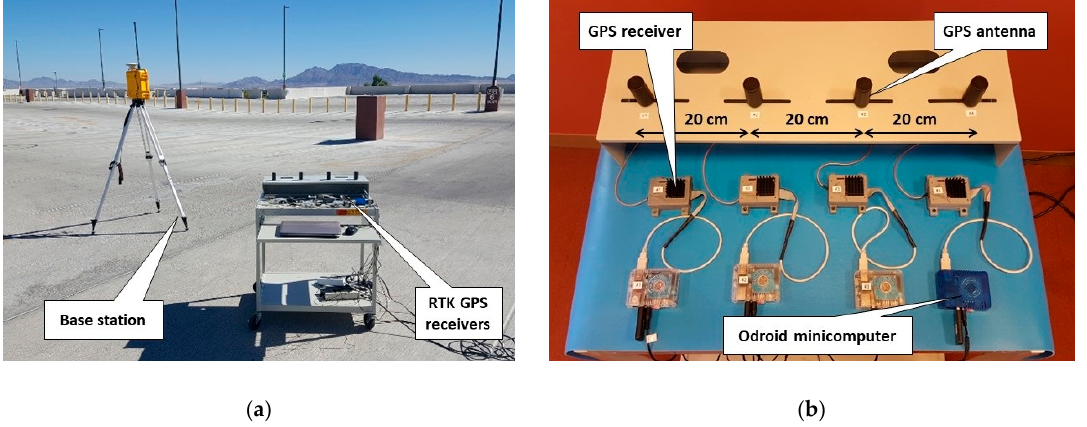
Figure 8. ( a ) Experiments using RTK GPS sensors; ( b ) antennas and receivers connected to UAS minicomputers.